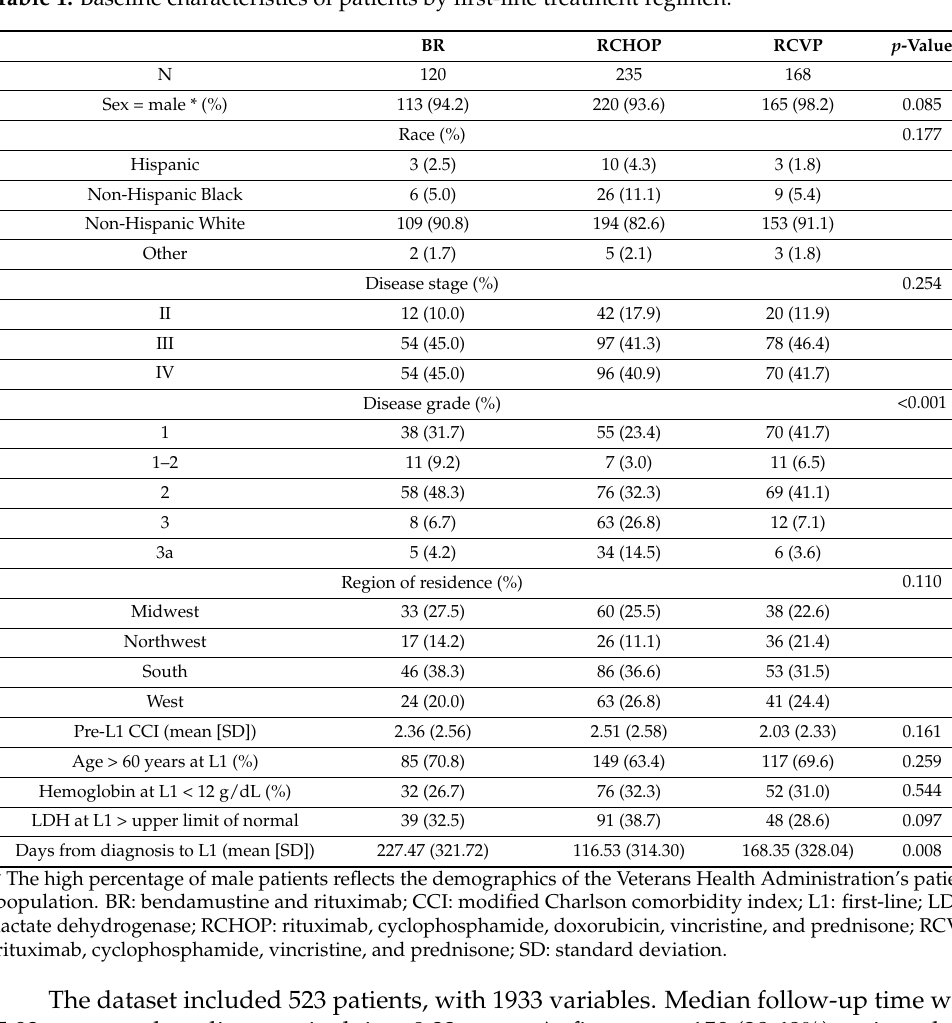
Table 1. Baseline characteristics of patients by first-line treatment regimen.